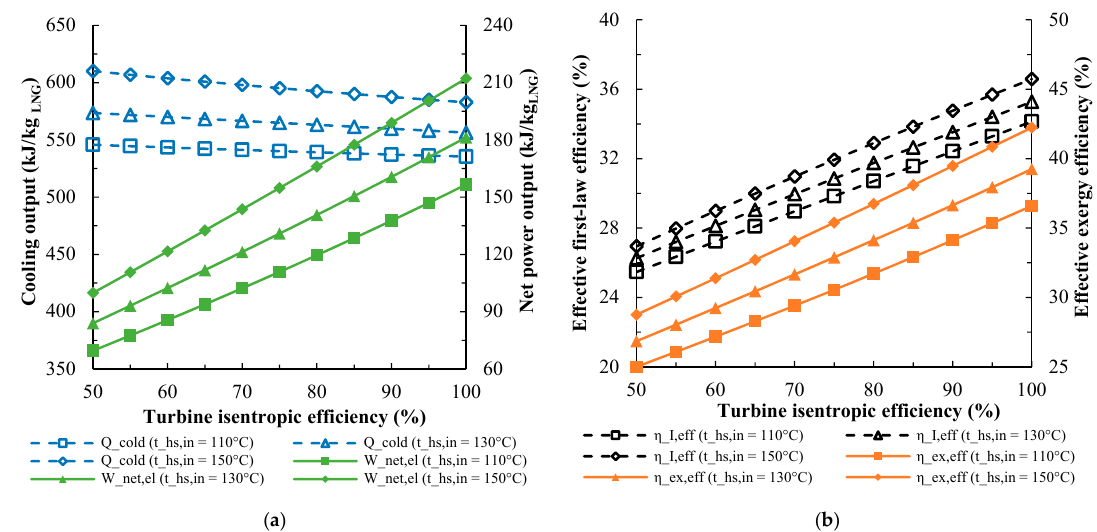
Figure 7. Effect of KC sub-system turbine isentropic efficiency on poly-generation system performance at different heat source temperatures ( t 18 = 110 ◦ C, 130 ◦ C and 150 ◦ C): ( a ) Useful cooling and electrical power outputs; ( b ) Overall efficiencies.